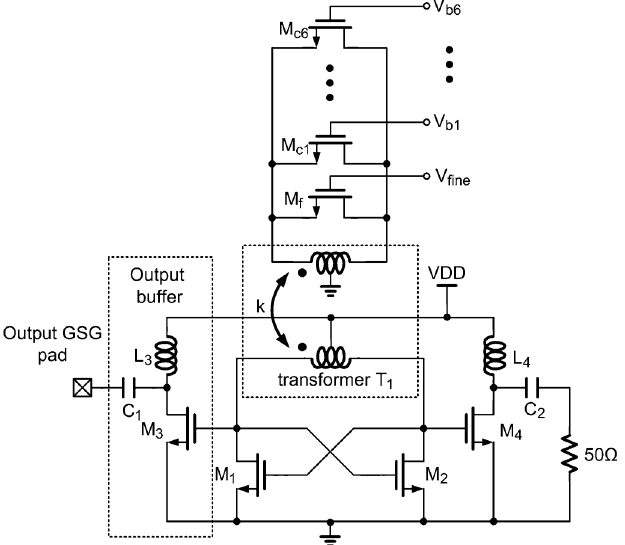
Figure 15. VCO schematic